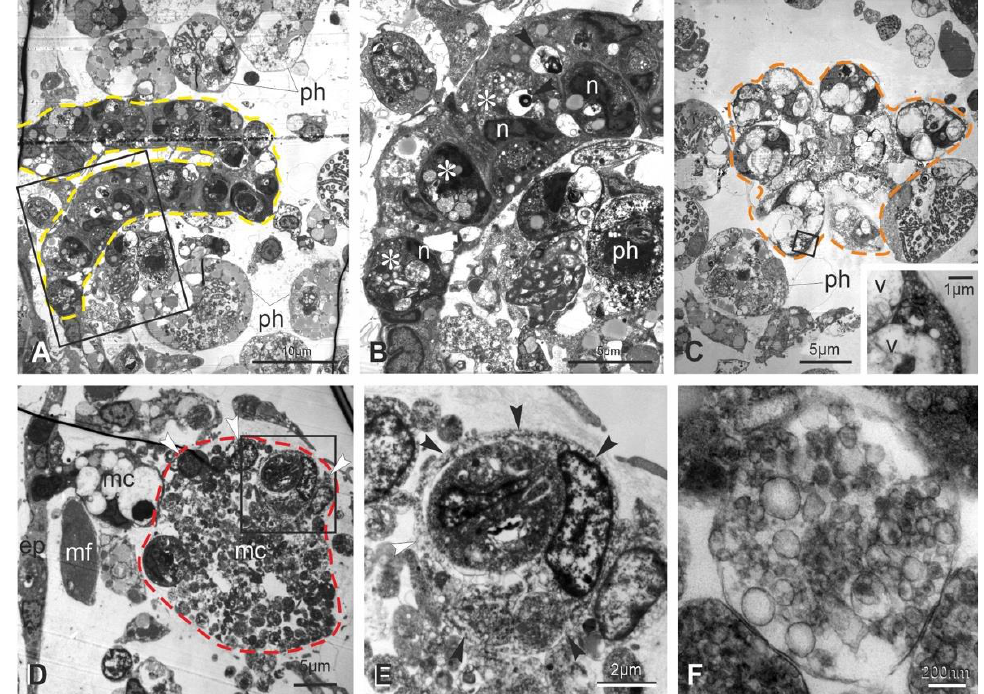
Figure 5. Ultrastructure of the neural complex in regressing zooids at sub-stages 11 4 . TEM. ( A , B ) Ciliated duct (yellow dotted line in A ); squared area in ( A ) is enlarged in ( B ). Severe signs of cell degeneration are represented by lobed and pyknotic nuclei (n), large autolysosomes (asterisks), degradative multilamellar bodies (arrowheads). Phagocytes (ph) are in the surrounding hemocele. ( C ) Neural gland constituted of very few cells. Squared area is enlarged in inset to show in cytoplasm both small vesicles and degradative vacuoles among large vacuoles (v). Phagocytes (ph) are in the surrounding hemocele. ( D – F ) Cerebral ganglion (red dotted line in D ) containing very few degenerated neurons (white arrowheads). The medulla (md) is loose and vacuolated, and neuritis ( F ) are filled with small vesicles ranging between 25 and 100 nm in diameter. Squared area in ( D ) is enlarged in ( E ) to show a phagocyte (black arrowheads) infiltrated into the ganglion. ep: epidermis; mc: morula cell; mf: muscle fiber.